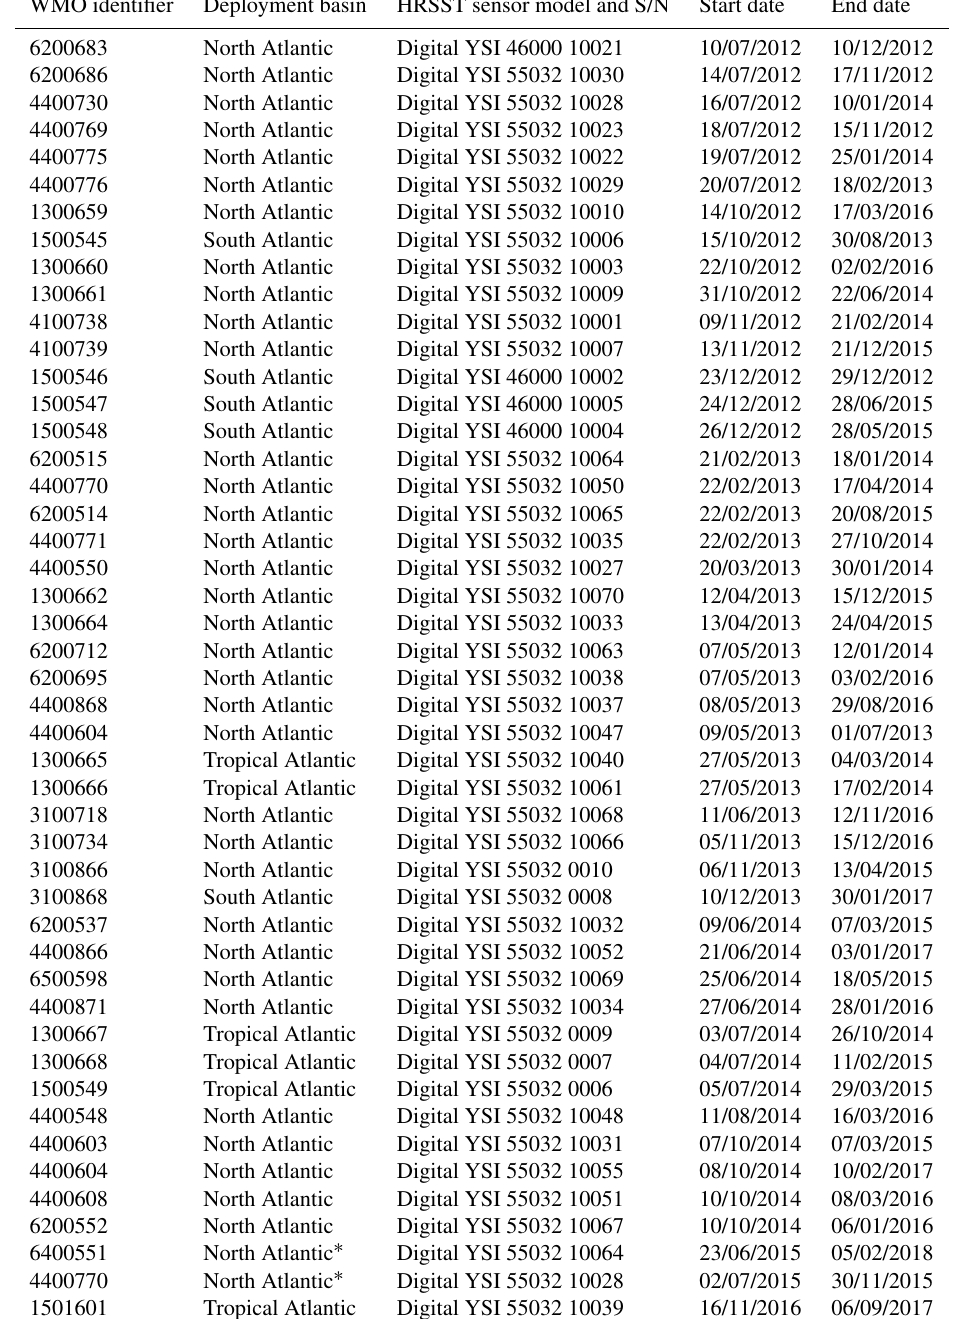
Table 1. Mission report of HRSST-2 SVP-B buoys. An asterisk indicates redeployment (note the WMO identifier may have changed, possibly reusing a number previously assigned to an earlier buoy). The third column shows SST sensor